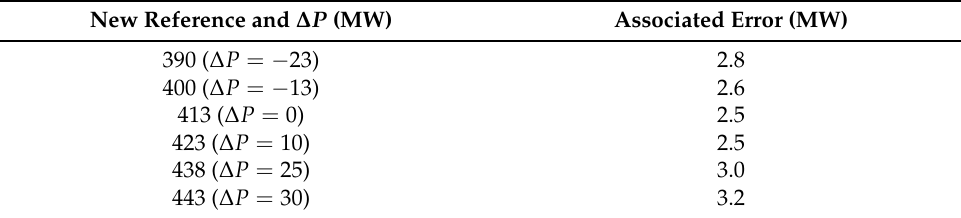
Figure 10. Power flow controlled by ETDC + MPC. Table 3. Errors obtained changing